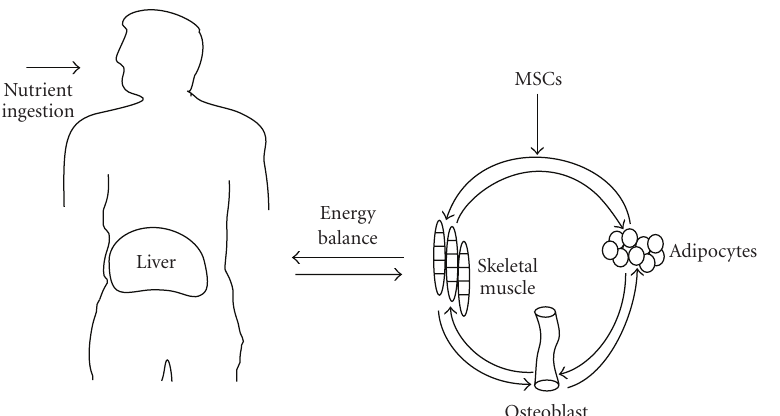
Figure 1: Nutrition and tissue-generated hormonal signals modulate mesenchymal stem cell di ff erentiation . Hormonal signals generated upon nutrient ingestion impact the organism’s energy balance, thus favoring anabolic versus catabolic activities. In turn, hormonal signals gener- ated by target tissues such as muscle, bone, and fat modulate MSC di ff erentiation into adipocytes or